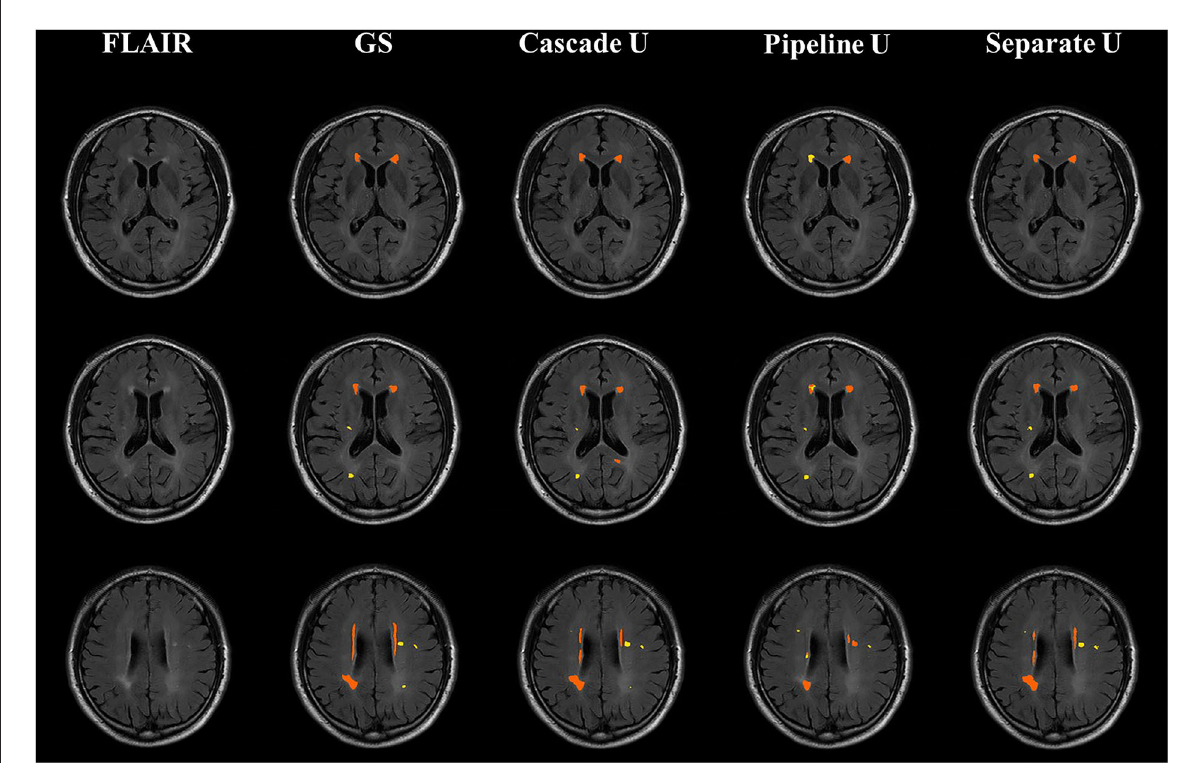
FIGURE5 Illustration of segmentation results from a subject with Fazekas score of 3. From left to right were T2-FLAIR images, the gold standard, Cascade U prediction results, Pipeline U prediction results, and Separate U prediction results. Orange represented pvWMHs, and yellow represented dWMHs. GS, gold standard.